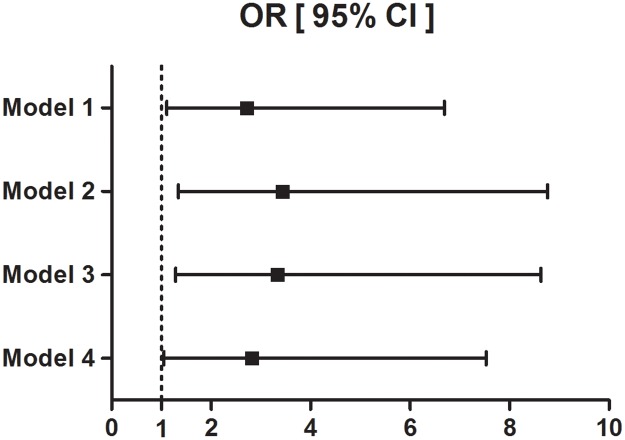
Odds ratio for significant coronary artery stenosis according to the CLO test.Logistic regression was used for calculating odds ratios with 95% confidence intervals. The reference group comprised the CLO-negative subjects.Model 1: Not adjustedModel 2: adjusted for age and sexModel 3: adjusted for age, sex, HDL-cholesterolModel 4: adjusted for age, sex, systolic BP, fasting glucose, HDL-cholesterol, anti-hypertension medication, anti-diabetic medication, lipid lowering agent, anti-platelet agentAbbreviations: OR, odds ratio; CI, confidence interval; BP, blood pressure; HDL-cholesterol, high density lipoprotein-cholesterol.